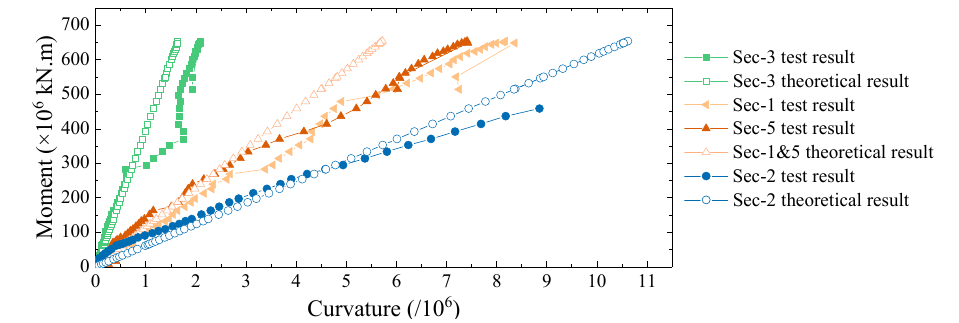
Figure 13. Moment-curvature curves of critical sections.